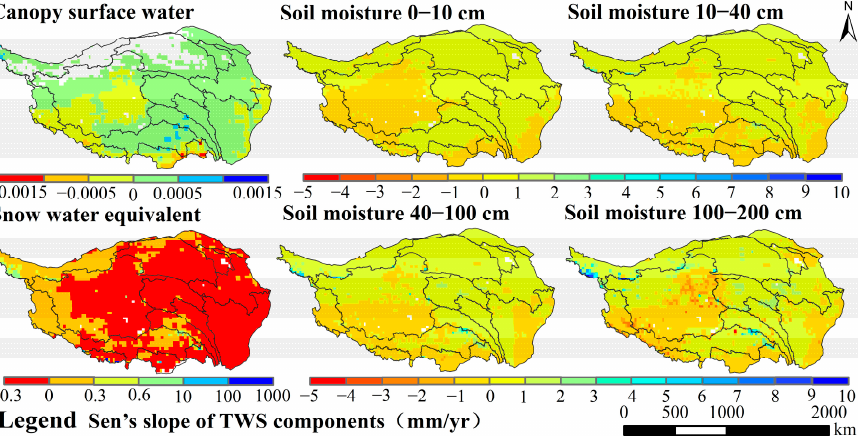
Figure 7. Spatial distributions of the trends in the terrestrial water storage components over the Tibetan Plateau.